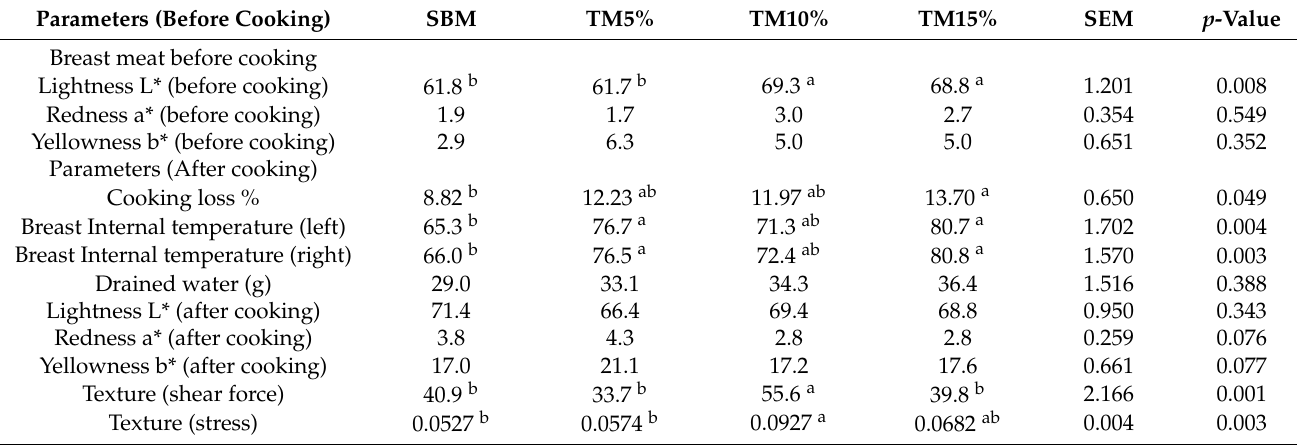
Table 4. Physical properties of carcass without internal viscera of Boschveld indigenous chickens fed soybean meal (SBM) or Tenebrio molitor larvae meal (TML) at 60 day of age.